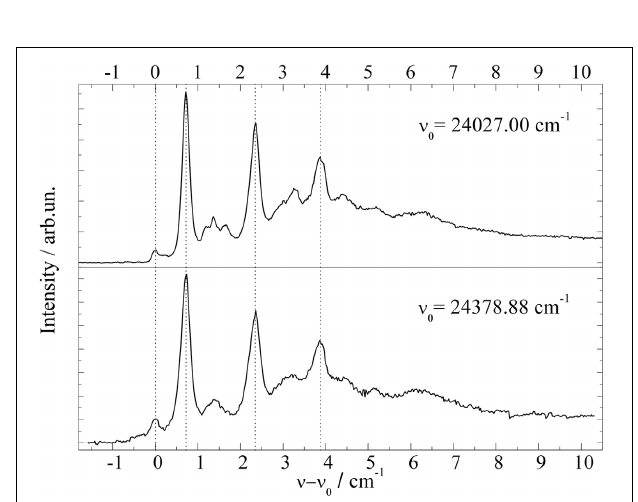
FIGURE 7 | Fluorescence excitation spectrum of Perylene at the electronic origin (top panel) and at a vibronic transition (bottom